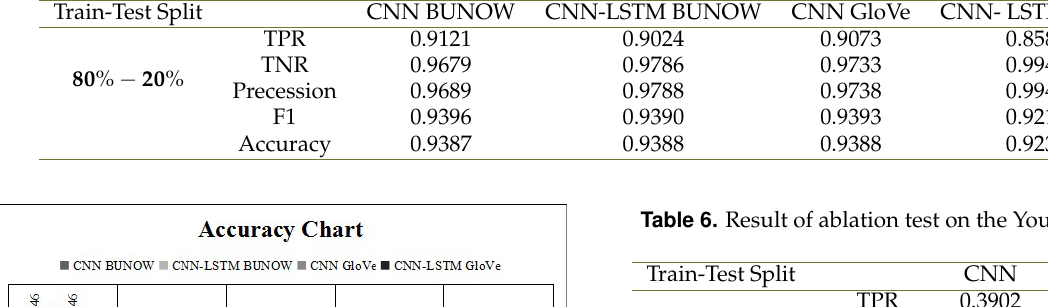
Table 5. Performance measures of the Youtube data set for 80% – 20% train-test split. Train-Test Split